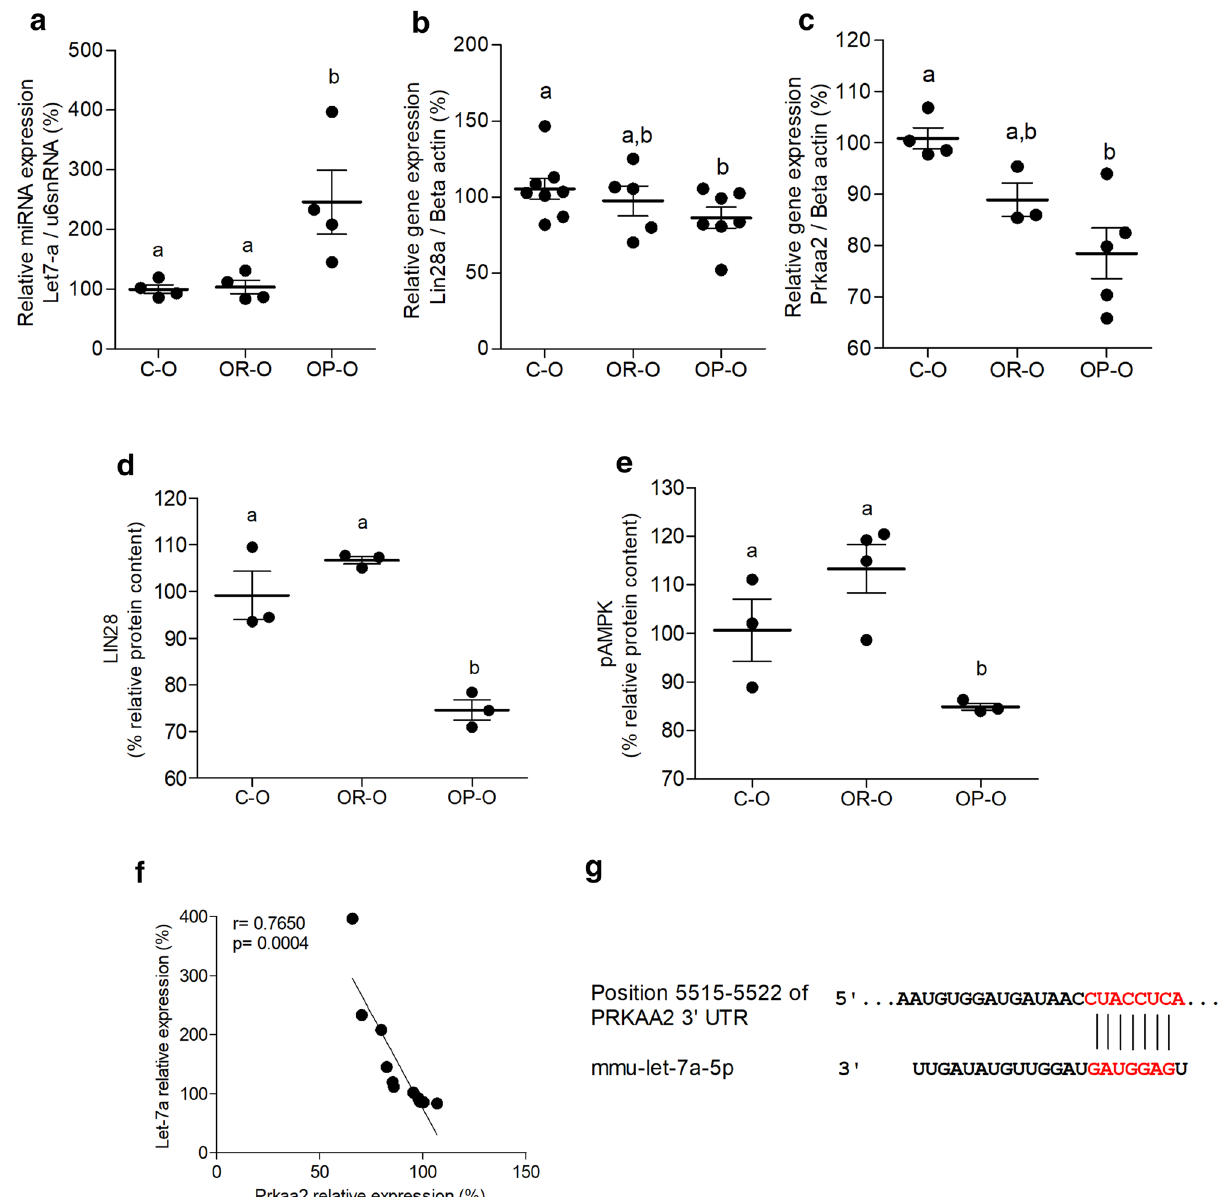
male offspring from control (C–O), obesity-resistant (OR–O) and obesity-prone (OP–O) dams at the delivery day (d0) (n = 3–8 pups/group). Pearson correlation and linear regression of hepatic levels of Let-7 a and Prkaa2 (n = 11) (f) , predicted pairing of target region of Prkaa2 mRNA (top) and Let-7a miRNA (bottom), according to TargetScan, release 7.2 (g) . One-way ANOVA were used to compare groups. Bonferroni post-hoc test was used to determine a significance level of p ≤ 0.05. Values are means with their standard errors represented by vertical bars. Different letters indicate statistical significance between